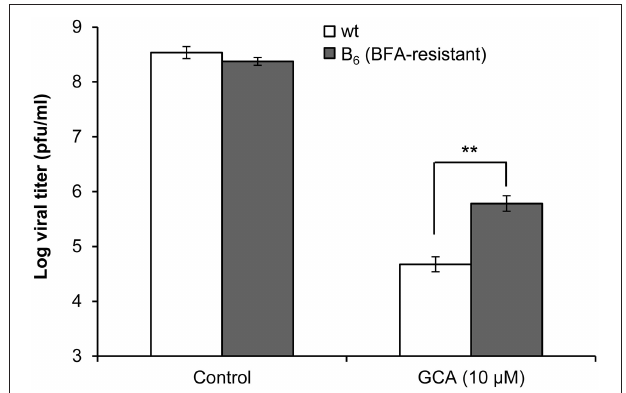
FIGURE 7 | The amino acid substitution Q65H in 2C confers resistance to GCA. IBRS-2 cells treated with 10 µ M GCA for 30 min were infected with SVDV wt or SVDV B 6 (moi of 0.5 pfu/cell) in presence of the drug. At 8 h pi the viral titer was determined by plaque assay. Error bars represent SD. Data